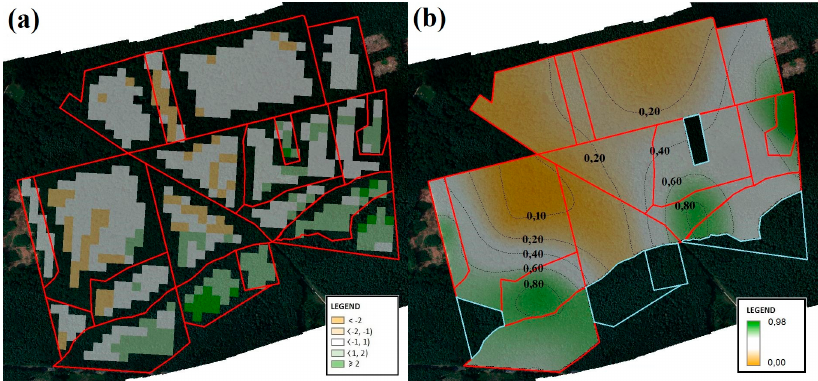
Figure 3. Surface representation of the mean Green Normalized Difference Vegetation Index ( Δ GNDVI) differential index between 2014 and 2015 ( a ). The mean value of the GNDVI differential index for 2014 and 2015 for all ROIs ( b ). The green color denotes the Shannon-Wiener diversity index values exceeding 0.60, the grey color represents those between 0.20 and 0.60, the orange color represents those below 0.20. Products at the surface reflectance level Landsat-8 OLI were used as source data. The study did not consider mixed pixels at the boundary of divisions. An improvement in the condition of trees is represented by the green color, while its deterioration is indicated by the orange color.